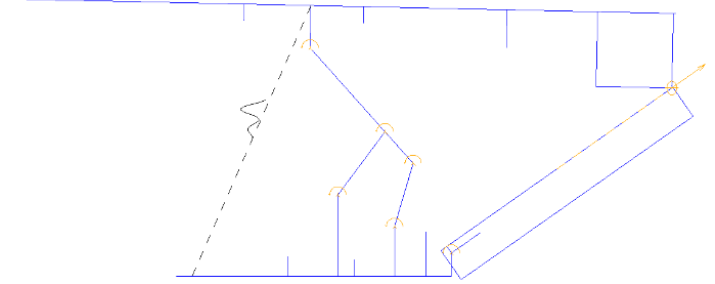
Figure 16. Skeleton of the ZC4800/16/30 backfilling hydraulic support.